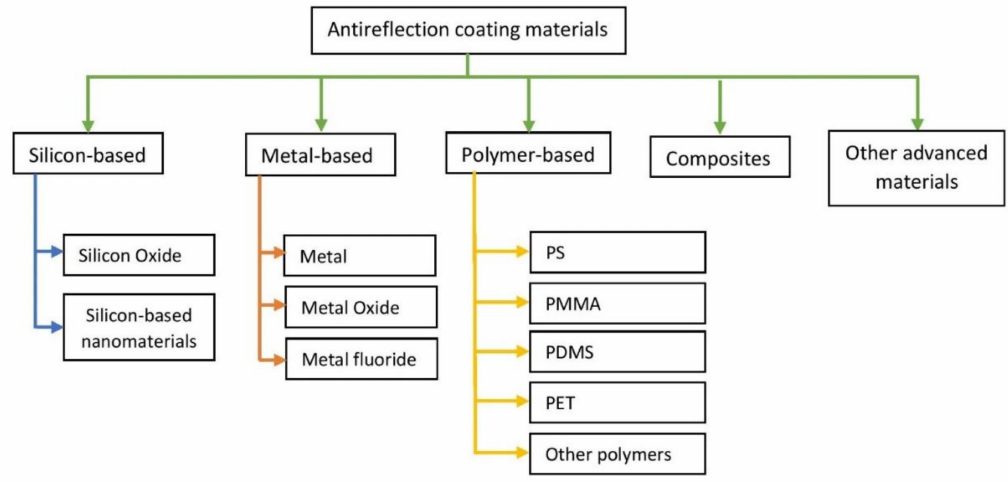
Figure 14. Classification of antireflection coating